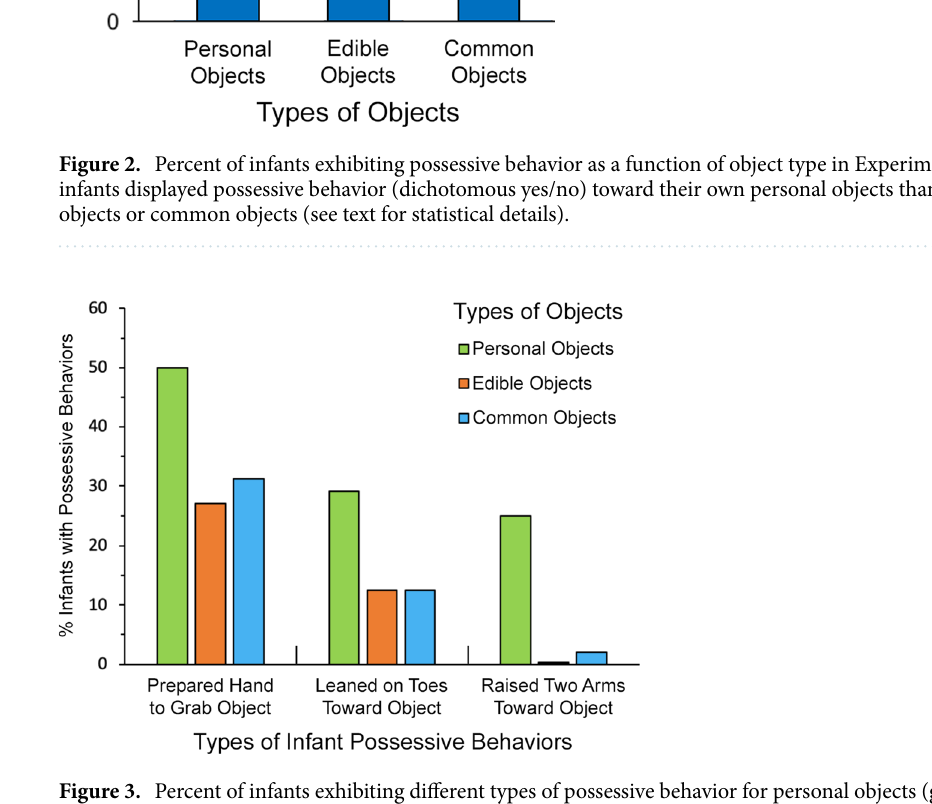
Figure 3. Percent of infants exhibiting different types of possessive behavior for personal objects (green), edible objects (orange), and common objects (blue) in Experiment 2. Each infant was scored for possessive behaviors (dichotomous yes/no) shown toward the objects. Three different kinds of infant possessive behaviors were scored (x-axis). For each type of infant possessive behavior, significantly more infants produced it for personal objects than for edible objects and common objects. This was assessed statistically using Cochran Q (2, N = 48) tests. (a) Prepared hand to grab object: Q = 7.92, P = 0.019, η 2 Q = 0.08. (b) Leaned on toes toward object: Q = 7.53, P = 0.023, η 2 Q = 0.08. (c) Raised two arms toward object: Q = 22.17, P = 0.00002, η 2 Q =